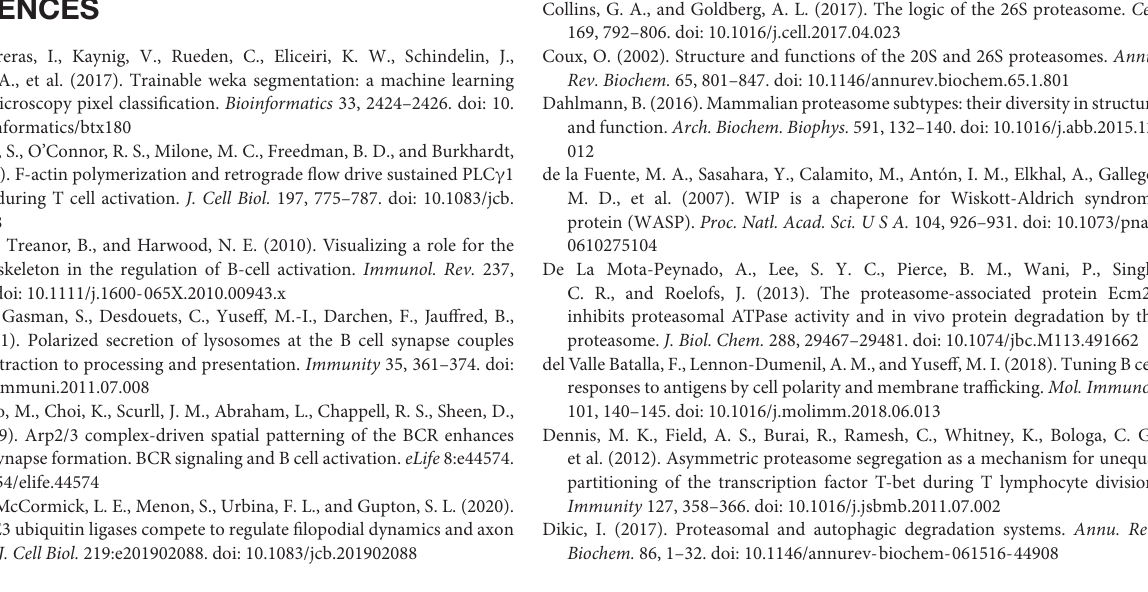
Supplementary Figure 4 | Proteasome recruitment and distribution at the IS rely on Ecm29: (A) Representative Time-lapse images by TIRFM of control (siCTL) and Ecm29-silenced (siECM29) B cells after 30 min of activation on antigen-coated coverslips, probed with 5 nM Bsc2118-FL-Bodipy (gray scale). The cell boundary (black line) delimited by the LifeAct-mCherry signal (mask) and accumulation of tracks are shown. The coldest colors represent the fastest tracks.